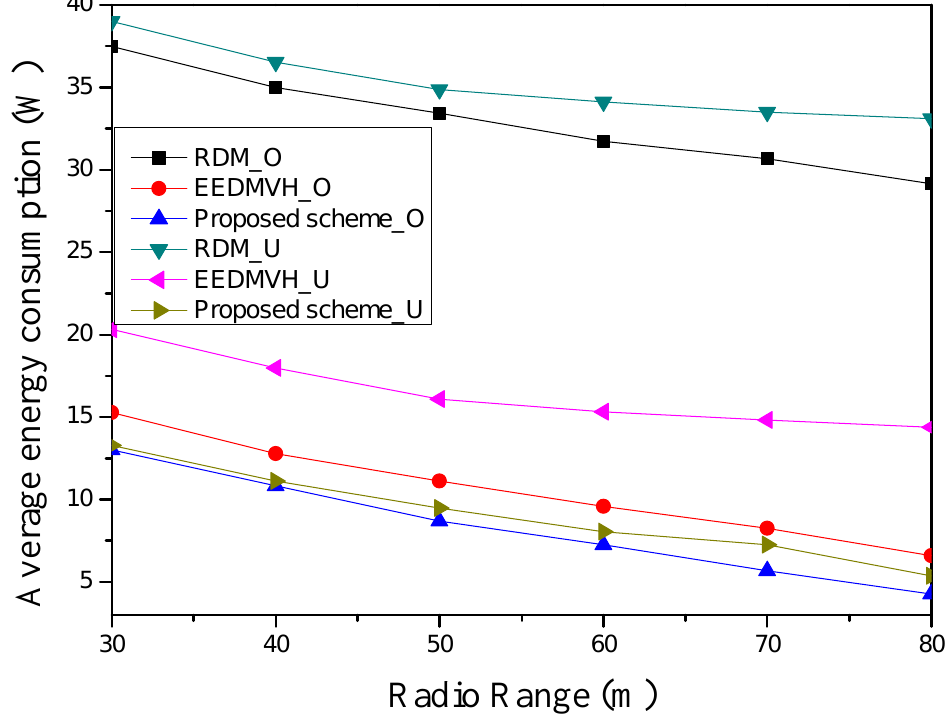
Figure 10. Average energy consumption according to the radio range of each